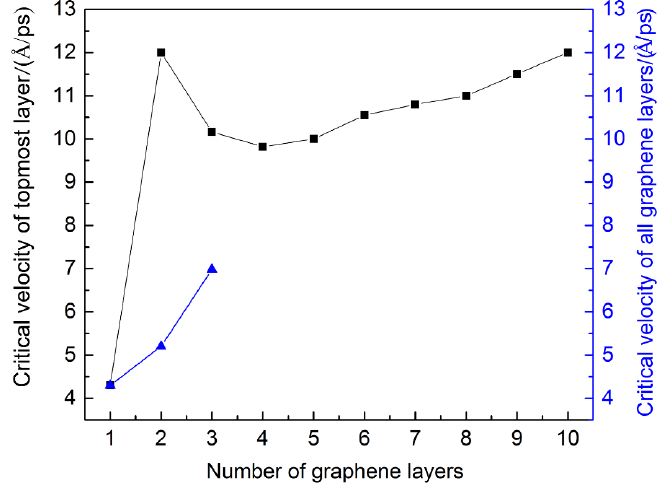
Figure 15. The critical velocities required to exfoliate the topmost layer and all layers of graphene for different numbers of graphene layers.